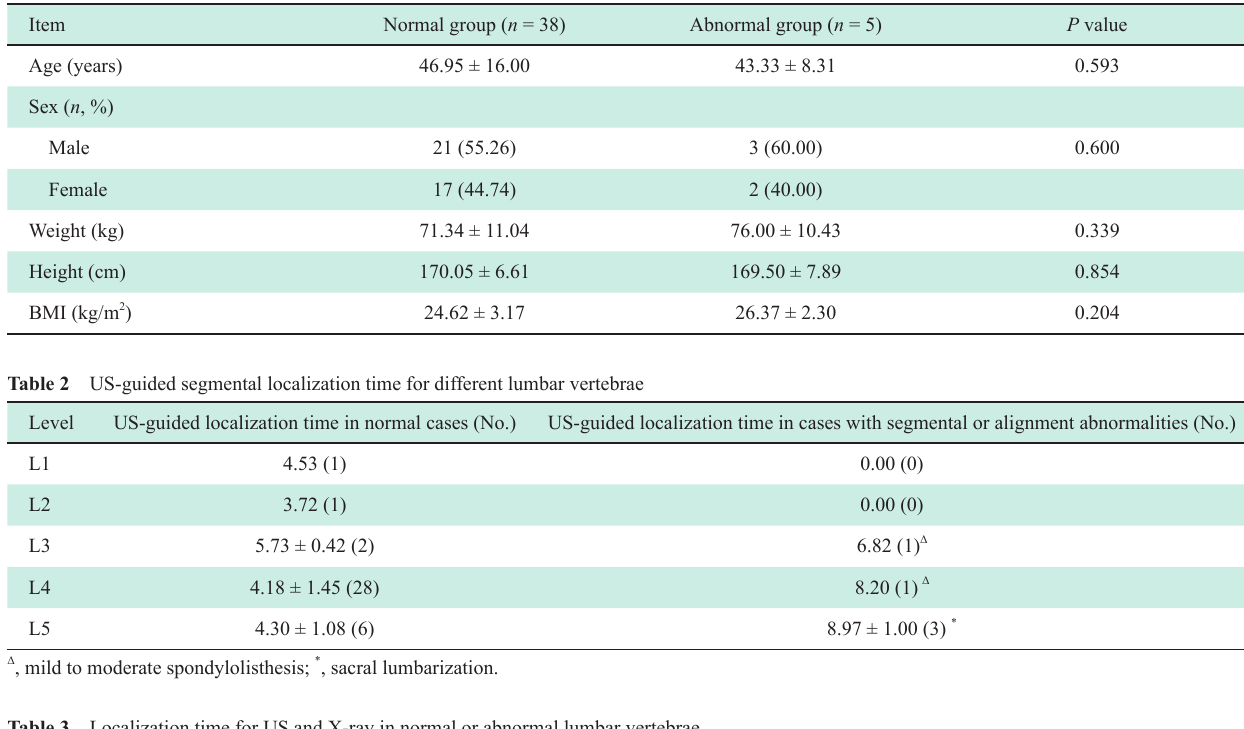
Table 3 Localization time for US and X-ray in normal or abnormal lumbar vertebrae Segmentation